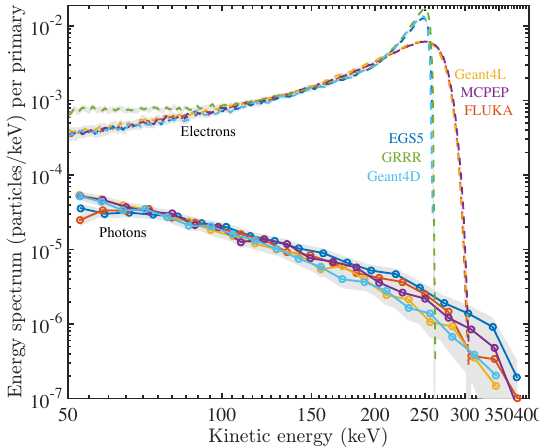
Figure 2. Products of a beam of 400keV electrons after a propaga- tion distance of 0.5 times their CSDA range which is 1.9m in air at 1bar and 273K. The electrons have now a maximal energy of 250 to 300keV depending on the code, but the total integrated en- ergy is equivalent. The difference in electron distribution is due to straggling by ionization; see Sect.